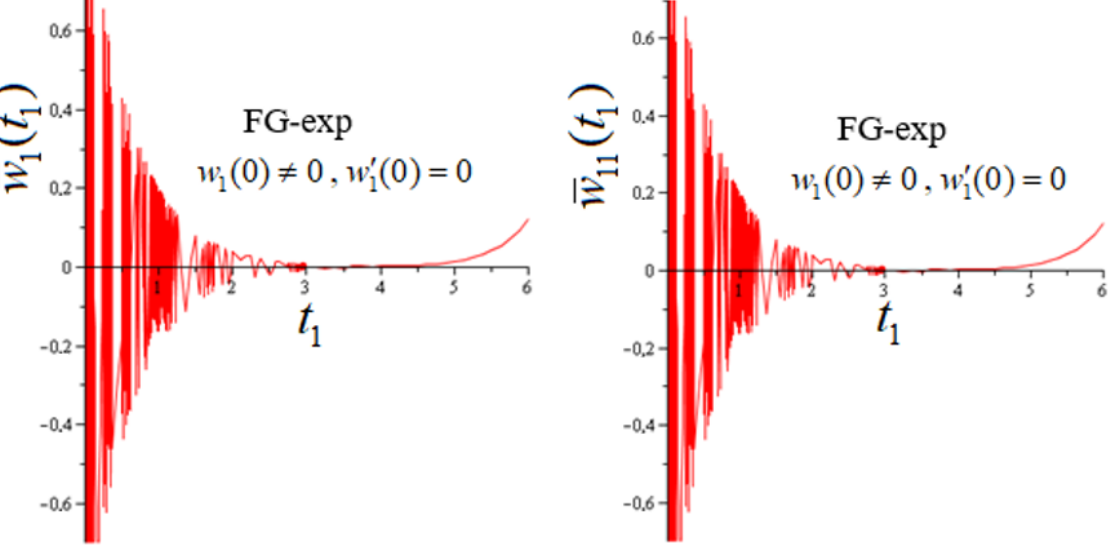
Figure 3. Variation of the deflection function of FG-VE-Ps on VE-Fs according to Equation (19) for the initial conditions w 1 ( 0 ) (cid:54) = 0, w (cid:48) 1 ( 0 ) =